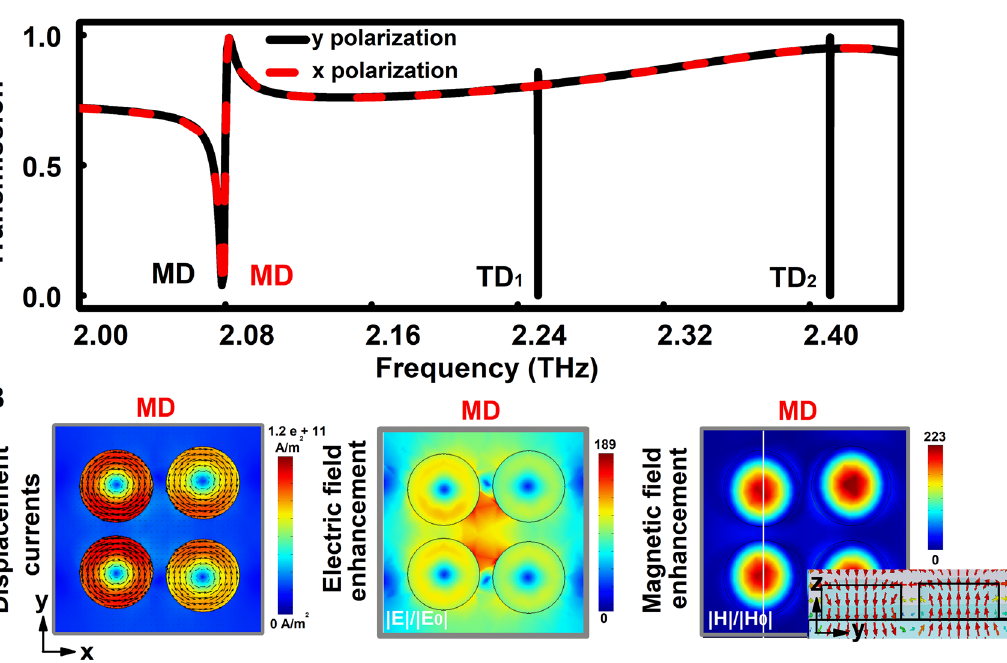
Figure 4: (A) Transmission spectra of the asymmetric metasurface structure ( a = 0.4 μ m) under the y -polarization (black solid line) and x -polarization (red dashed line). (B) Cross-sectional patterns of displacement currents, electric fi eld enhancement, and magnetic fi eld enhancement at MD resonance for x -polarization in the x – y plane with z -axis corresponding to the half-height of the cylinder.